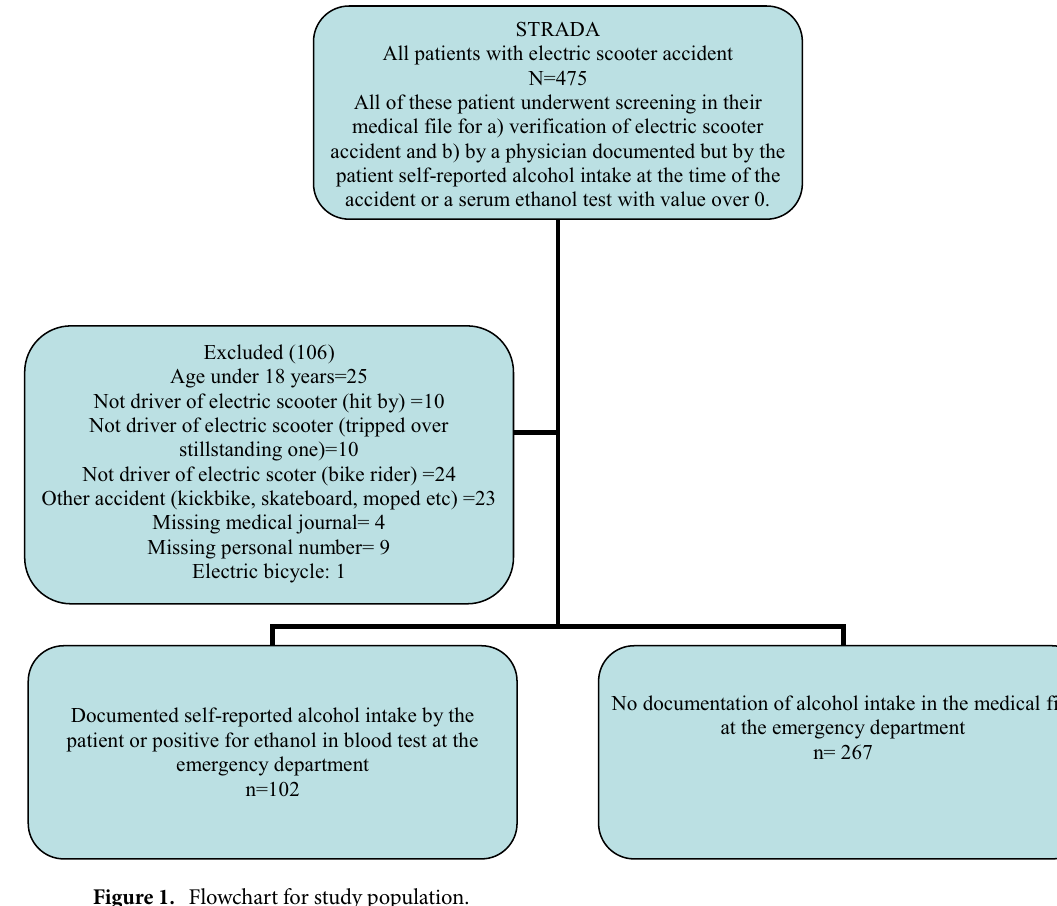
Figure 1. Flowchart for study